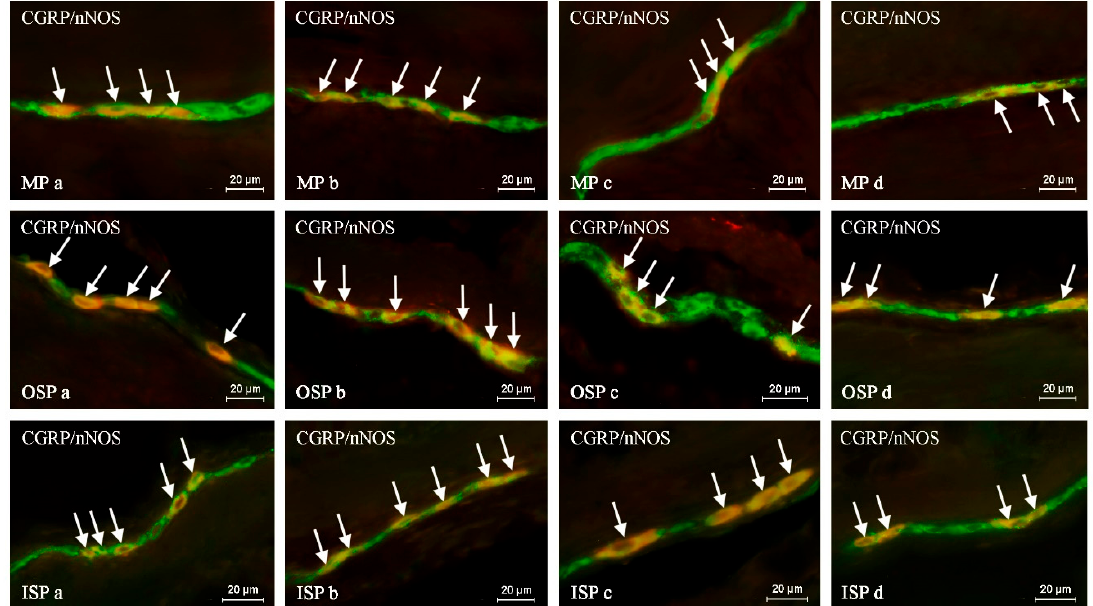
Figure 3. The representative images of the co-localization of calcitonin gene-related peptide (CGRP) with neuronal isoform of nitric oxide synthase (nNOS) in the neurons of the myenteric plexus (MP), outer submucous plexus (OSP) and inner submucous plexus (ISP) of the porcine descending colon under physiological conditions in young females ( a ), young males ( b ), adult females ( c ) and adults males ( d ). Images are composites of merged photographs taken separately from green (CGRP) and red (nNOS) fluorescent channels. Nervous structures where CGRP co-localizes with nNOS are indicated by arrows.